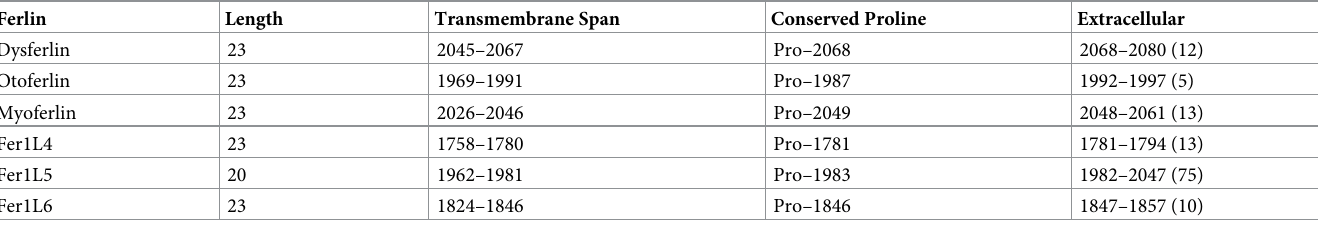
Table 2. Predicted ferlin transmembrane span boundaries and extracellular residues.